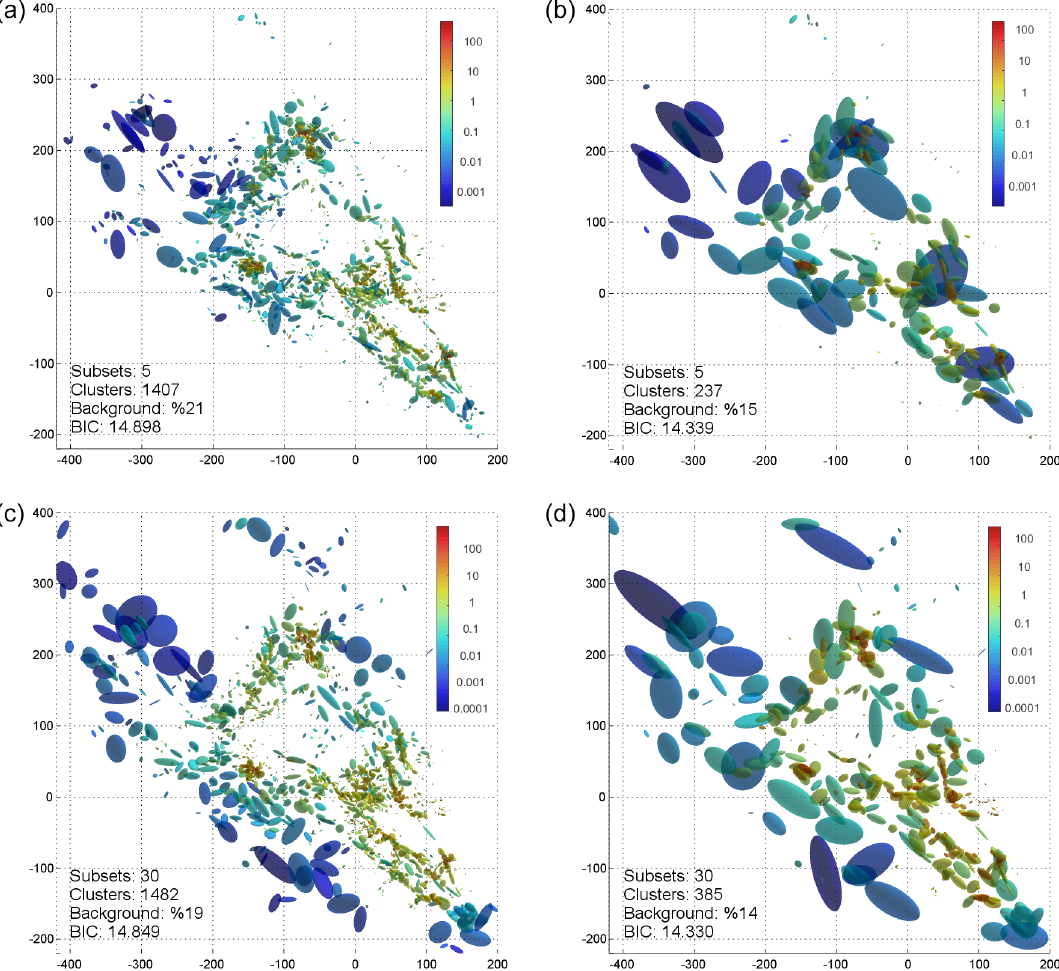
Figure 11. Fault network reconstructions for the KaKiOS-16 catalog. Panels (a, b) show results for the case of five initial subsets with (a) local and (b) global merging criterion. Bottom row shows the (c) local and (d) global merging criterion for 30 initial subsets. The number of clusters, background weight and BIC per data point is given in the insets. Clusters are colored according their density (data point per cubic kilometer), where the volume is estimated as the product of standard deviations along the principal component